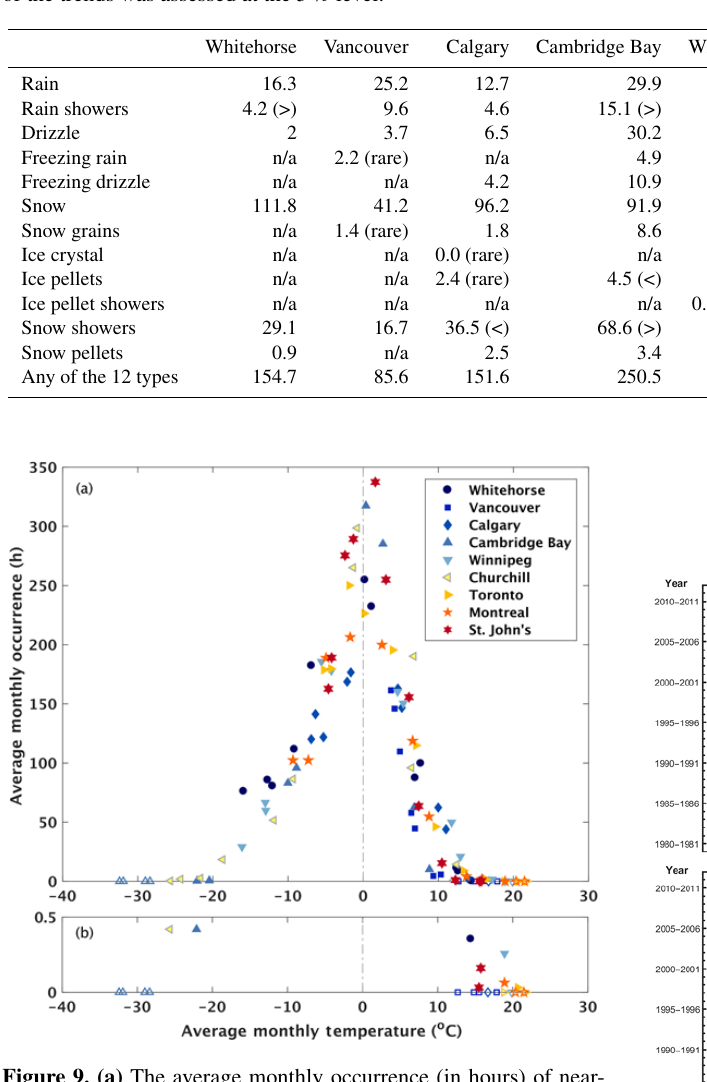
Figure 9. (a) The average monthly occurrence (in hours) of near- 0 ◦ C conditions as a function of the average monthly surface tem- perature for the nine selected stations over the 1981–2011 period. Filled symbols indicate occurrence, and open or unfilled symbols indicate no occurrence. Panel (b) provides an expanded view to bet- ter illustrate low values of average monthly occurrence.